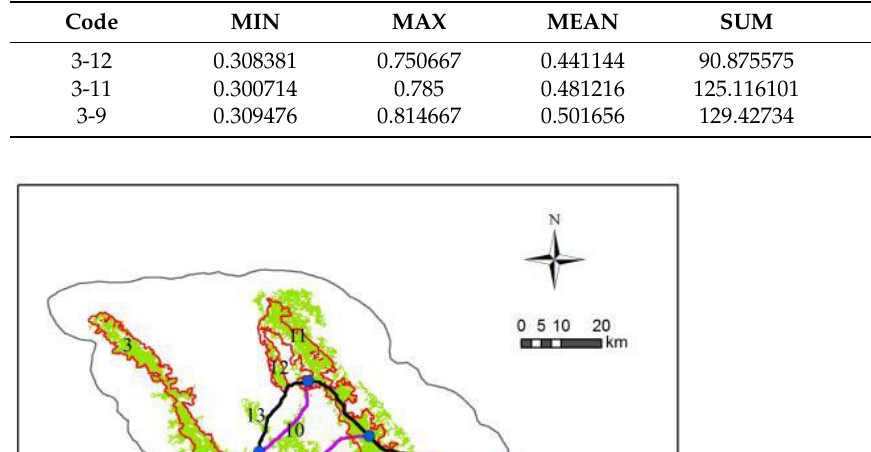
Table 5. Ecological corridor cost table.